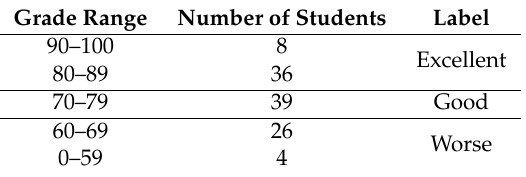
Table 3. Statistics of students’ final score distribution.